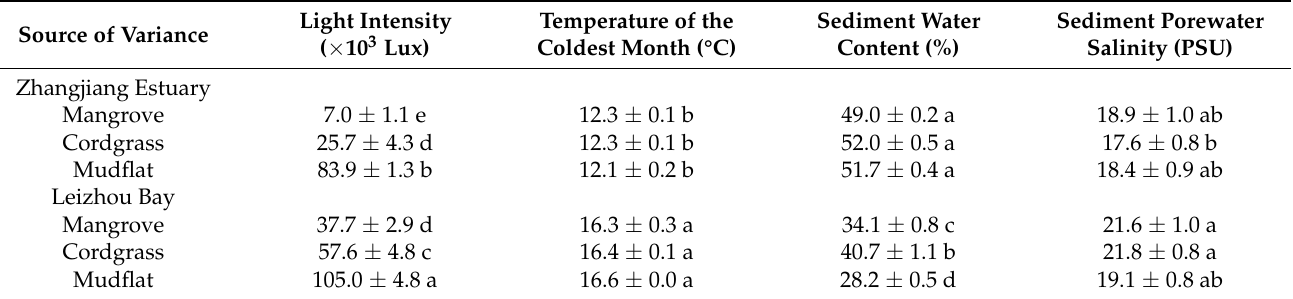
Table 1. Abiotic factors in three habitats in Zhangjiang Estuary and Leizhou Bay. Data are means ± SE (light intensity and air temperature of the coldest month: n = 3 per habitat at each site, sediment water content and sediment porewater salinity: n = 35~60 per habitat at each site). Tukey’s HSD significances (at the level of p < 0.05) are shown by different letters.